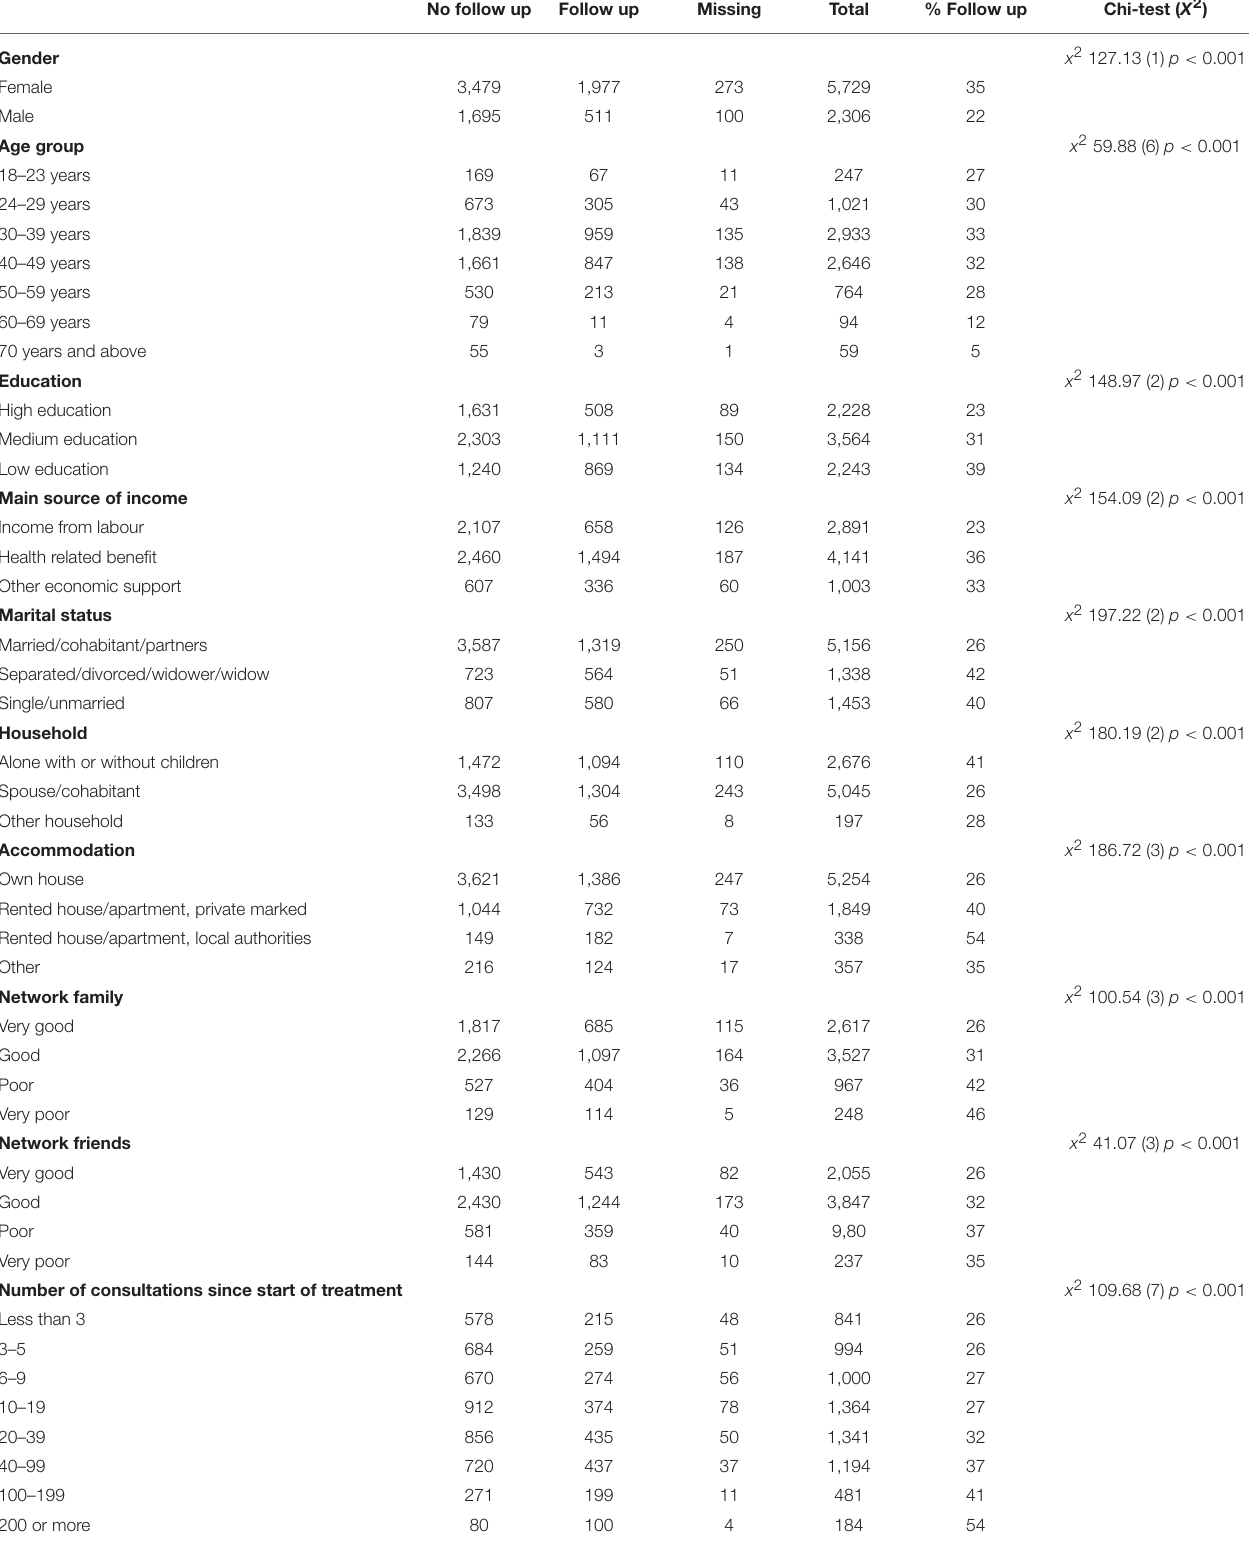
TABLE 6 | Bivariate analyses of characteristics of outpatients with children ( N = 8,035) * and whether measures have been taken to follow up their children. No follow up Follow up Missing Total % Follow up Chi-test ( X 2